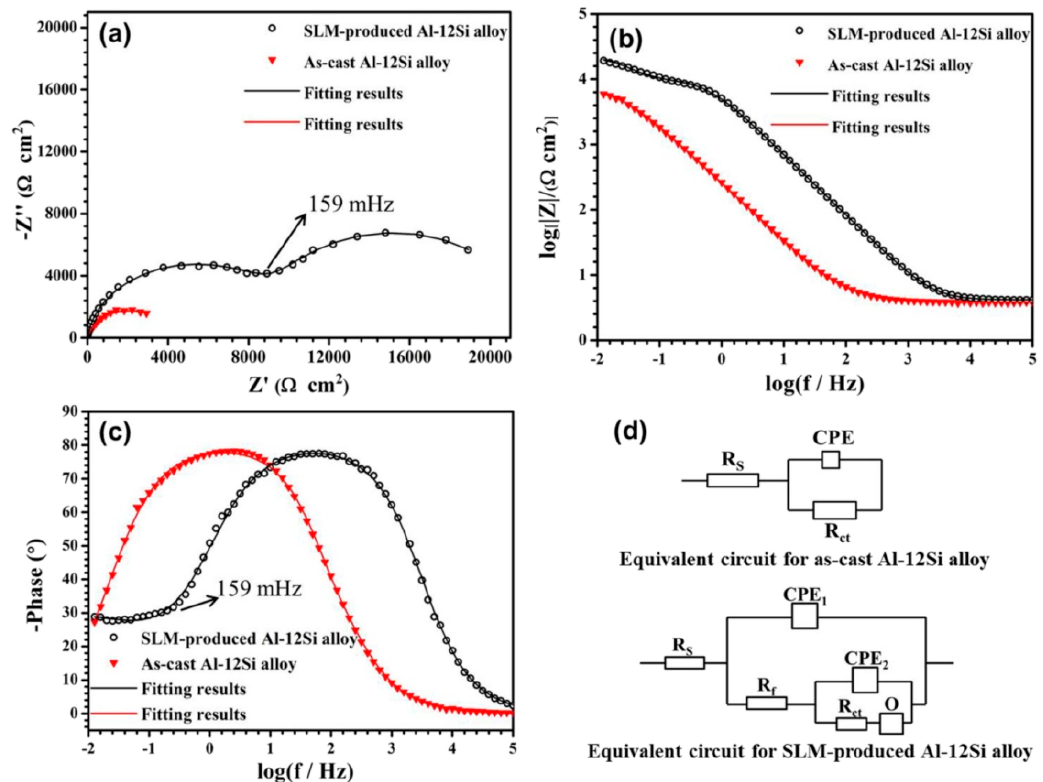
Figure 9. The EIS plots of SLM and casted Al-12Si aluminum alloy: ( a ) Nyquist plots; ( b , c ) Bode plots; ( d ) fitting equivalent circuit diagram [65].